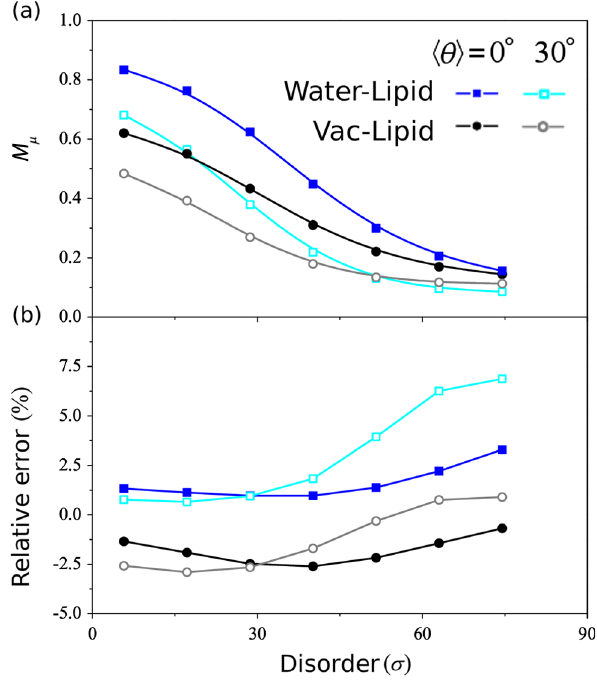
FIG. 7. Calculation of the signal modulation using the fast, approximate method. (a) Modulation as a function of the disorder parameter, similar to the predicted trend from the full numerical simulations. (b) Relative error between the two predictions, showing that the fast calculation is consistently within 10% (although generally even lower) of the numerical